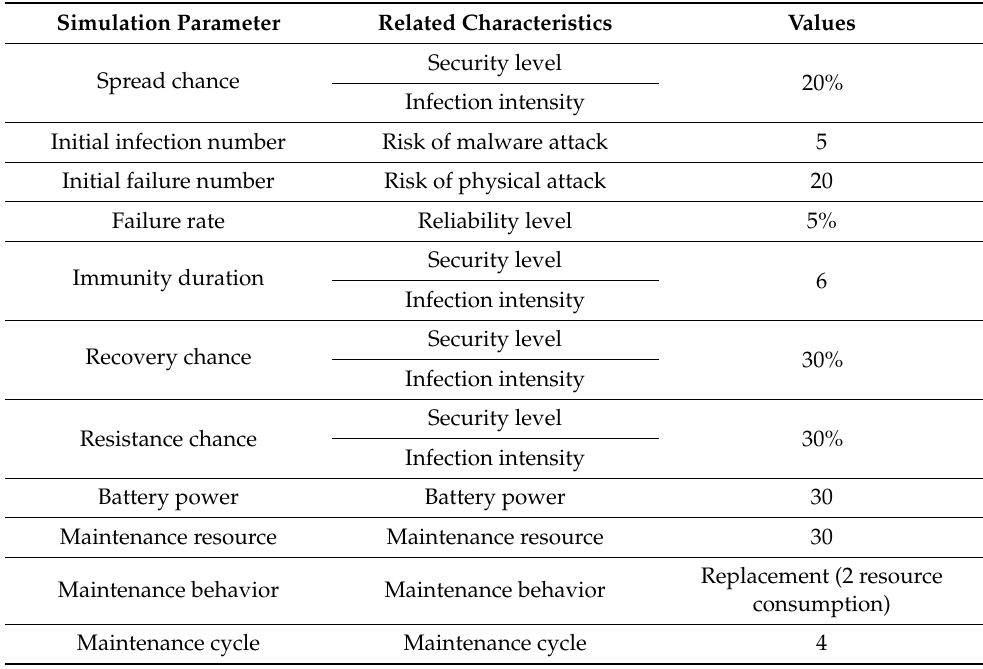
Table A2. Scenario 1 with simulation parameters and values.